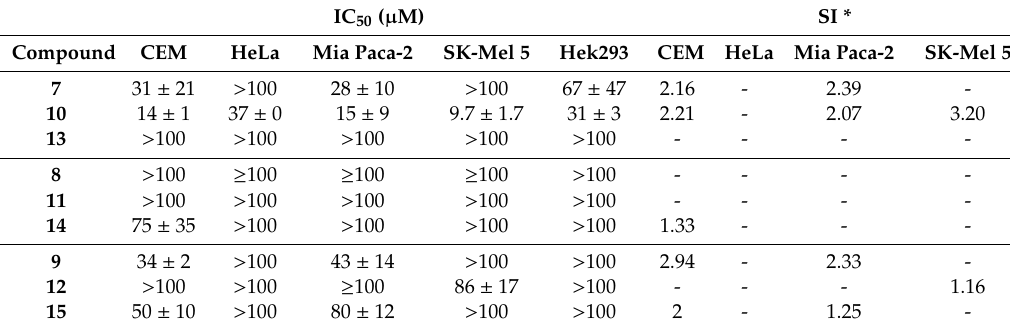
Table 5. Inhibitory e ff ects of benzimidazole derivatives on cell proliferation (CEM, HeLa, Mia Paca-2 and SK-Mel 5). All analyzes are the mean of triplicate measurements ± standard